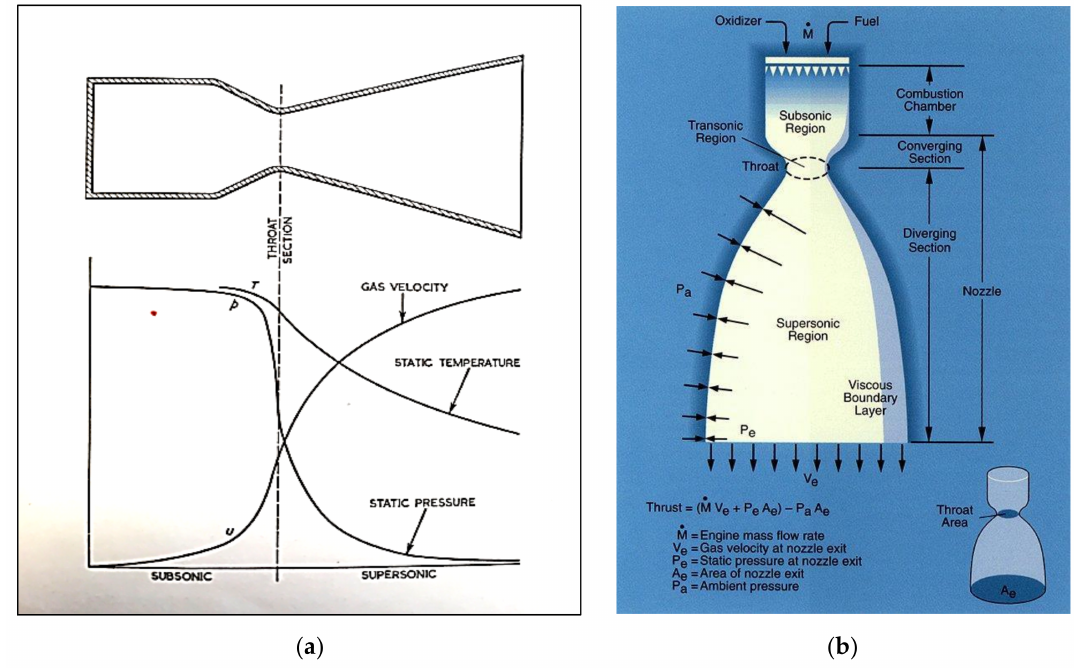
Figure 4. ( a ) Expansion in a convergent-divergent (C-D) supersonic nozzle and ( b ) nozzle geometrical